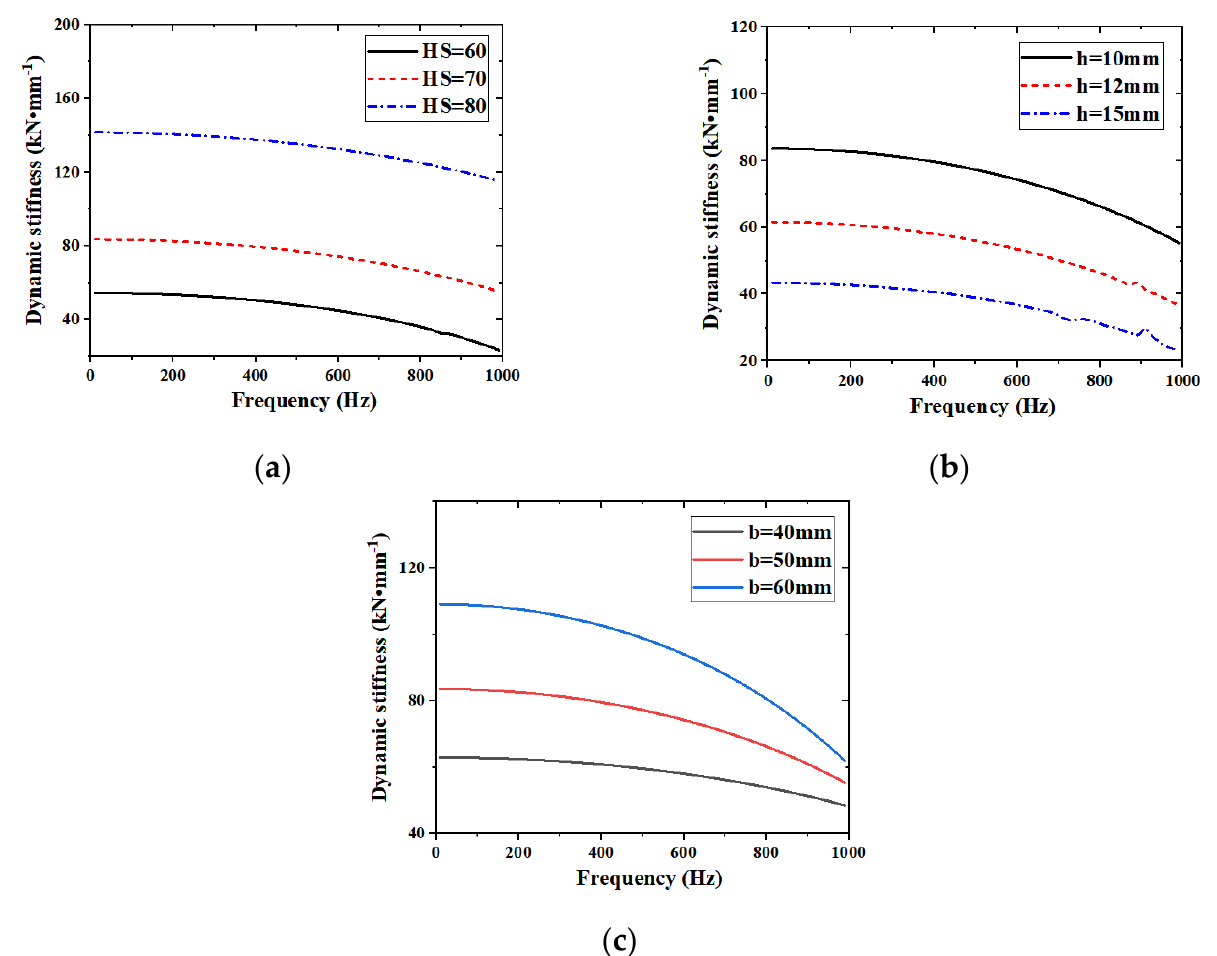
Figure 12. The dynamic stiffness of the first-stage vibration isolator with ( a ) different material hard- nesses, ( b ) different ring thicknesses, and ( c ) different ring widths.